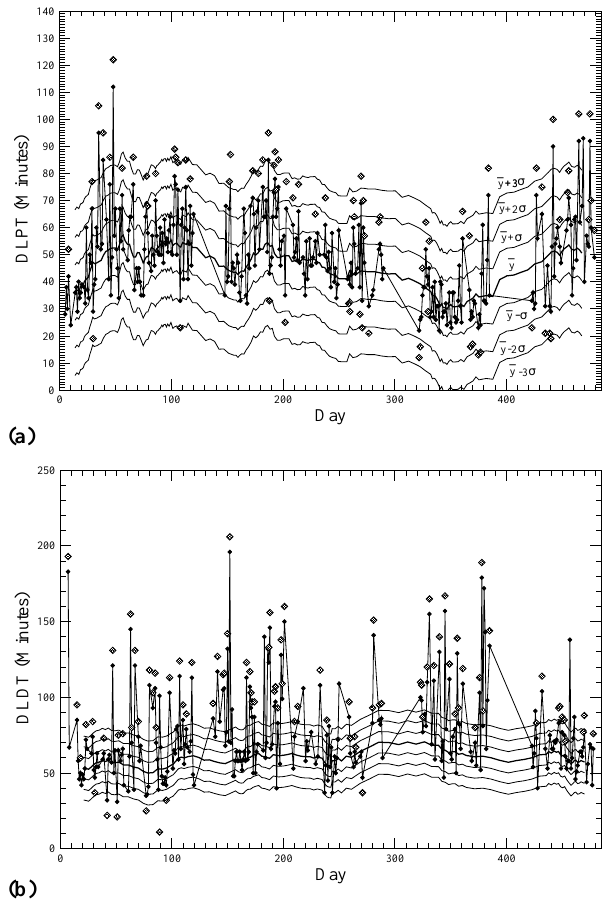
Fig. 3. Plots of (a) DLPT and (b) DLDT as a function of days. Dark Fig. 3. (a-b): Plots of (a) DLPT and (b) DLDT as a function of circles are actually observed values of DLPT and DLDT on a given days. Dark circles are actually observed values of DLPT and DLDT Fig. 3. (a-b): Plots of (a) DLPT and (b) DLDT as a function of day and the diamonds represent earthquakes which are “associated” on a given day and the diamonds represent earthquakes which are days. Dark circles are actually observed values of DLPT and DLDT with the anomalous data, even when the earthquake may have taken ‘associated’ with the anomalous data, even when the earthquake on a given day and the diamonds represent earthquakes which are place 2–3days later. The thick solid curve is the average of the Fig. 3. (a-b): Plots of (a) DLPT and (b) DLDT as a function of may have taken place 2-3 days later. The thick solid curve is the ‘associated’ with the anomalous data, even when the earthquake DLPT and DLDT values, and the thin solid curves are drawn at 1 σ , days. Dark circles are actually observed values of DLPT and DLDT average of the DLPT and DLDT values, and the thin solid curves may have taken place 2-3 days later. The thick solid curve is the 2 σ and 3 σ on a given day and the diamonds represent earthquakes which are are drawn at 1 σ , 2 σ and 3 σ apart. average of the DLPT and DLDT values, and the thin solid curves ‘associated’ with the anomalous data, even when the earthquake are drawn at 1 σ , 2 σ and 3 σ apart. may have taken place 2-3 days later. The thick solid curve is the average of the DLPT and DLDT values, and the thin solid curves are drawn at 1 σ , 2 σ and 3 σ apart.